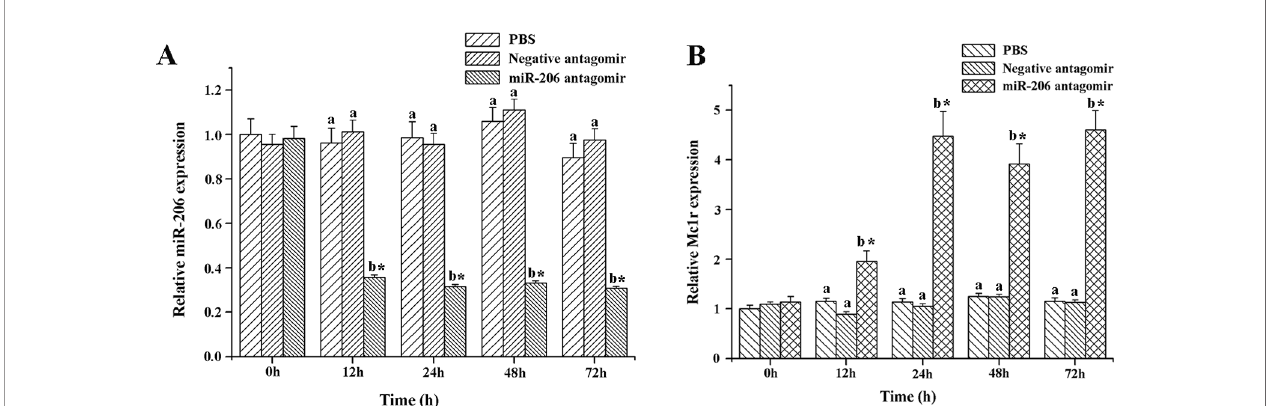
FIGURE 3 | Effect of miR-206 silencing on expression of miR-206 (A) and Mc1r gene (B) . Koi carp weighing ~10g were received a tail-vein injection with PBS, negative antagomir or miR-206 antagomir (dose, 40 mg/kg). Fish injected with PBS was taken as control. QRT-PCR analysis was used to detect relative expression, U6 and b -actin expression level was detected as the internal control. Asterisk (*) indicates a signi fi cant difference ( P < 0.05) in the same treatment before and after injection with Paired-samples t-test. Different lowercase letters show signi fi cant differences among treatments at each sampling point ( P < 0.05, Duncan's multiple range